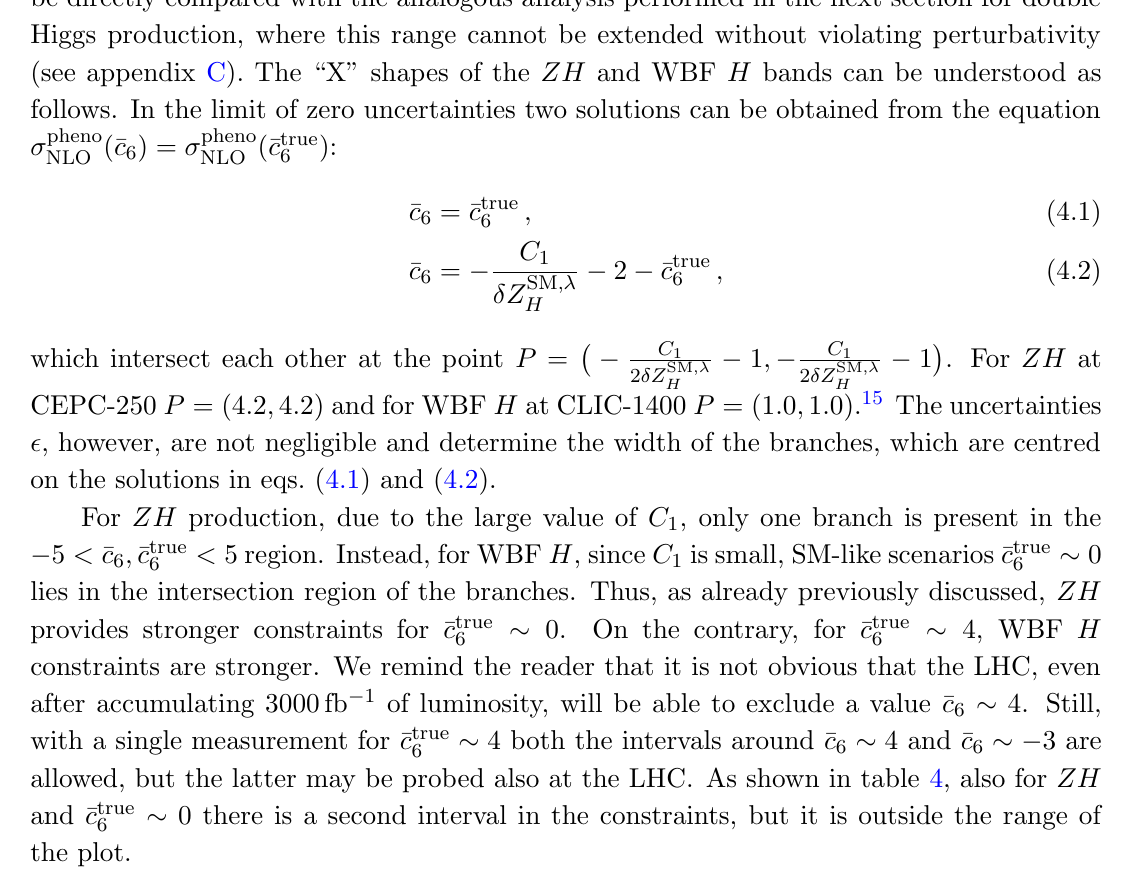
Figure 9 . The 2 (cid:27) bounds on (cid:22) c 6 as a function of (cid:22) c true described in the text. Two representative cases are considered: ZH at CEPC-250 and WBF H at